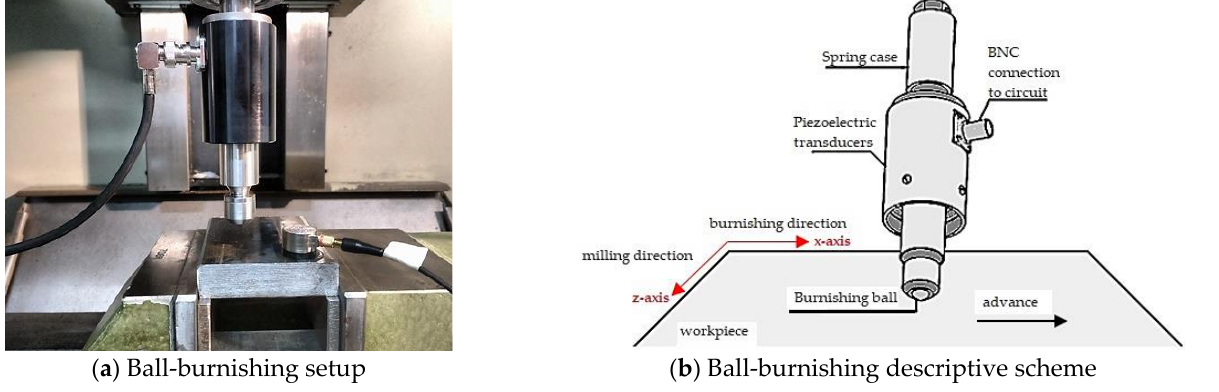
Figure 2. Ball-burnishing